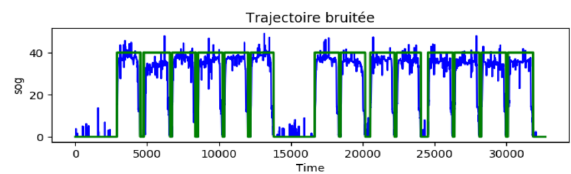
Figure 7 . Time evolution of the speed (blue) of a ship making round trips between two ports. In green the result of the noise-robust stop/move phase classification.